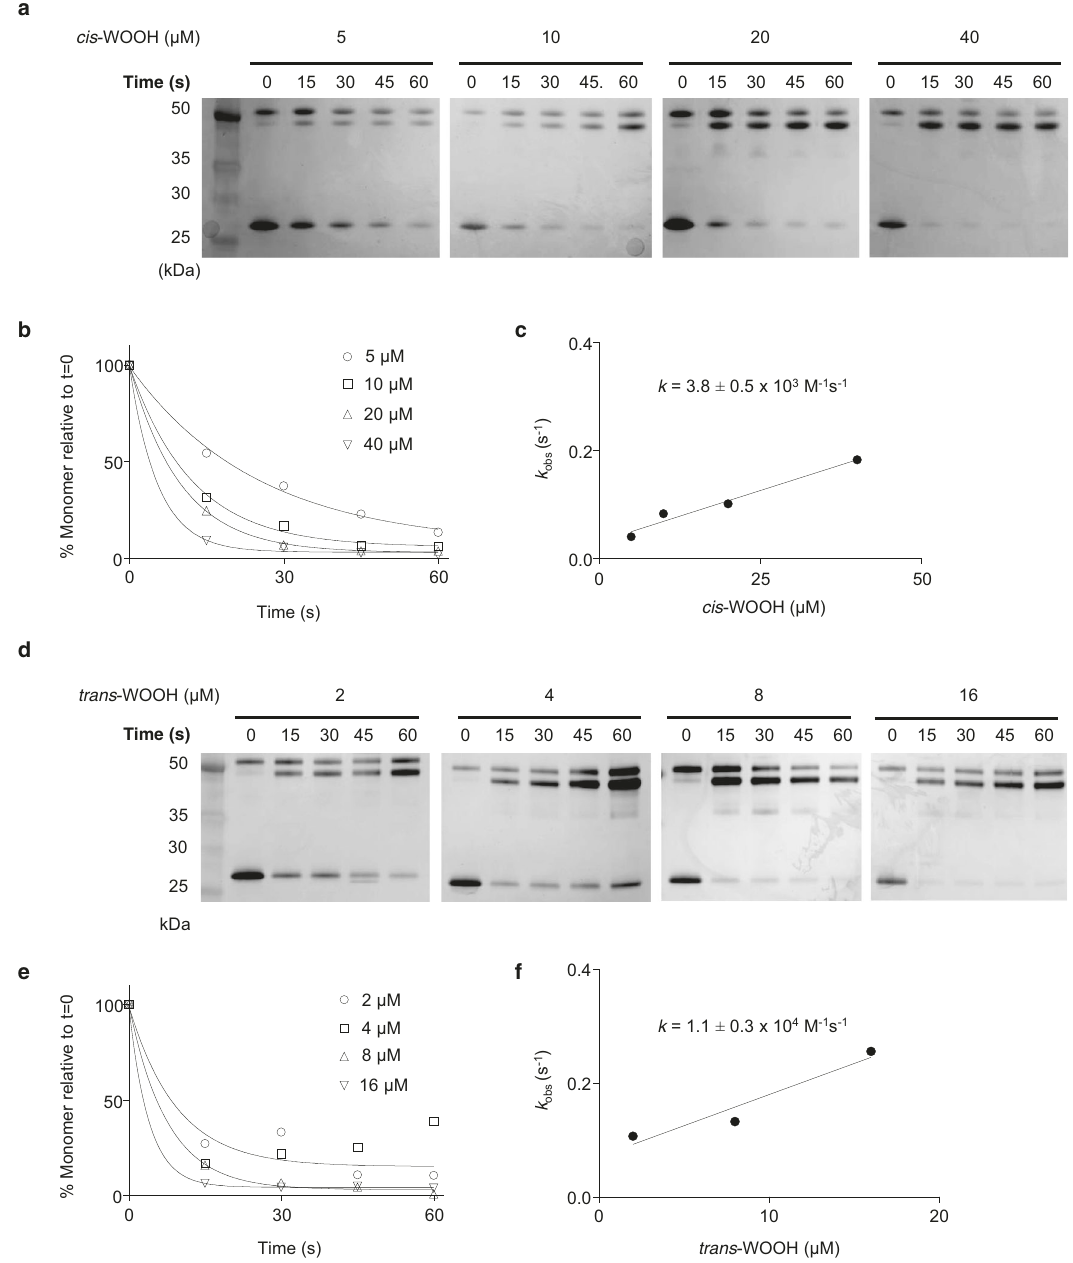
Fig. 3 Estimation of the rate constant for the reaction of cis - and trans -WOOH with His-tagged wild-type Prx2. a Reaction of Prx2 (5 μ M) with cis - WOOH (5 – 40 μ M) at 25 °C. After incubation, N -ethylmaleimide (NEM, 30 mM) was added, and the samples subjected to non-reducing 4 – 12% SDS-PAGE followed by silver staining of the gels. b Time course of monomer disappearance with increasing concentrations of cis -WOOH. c Determination of second- order rate constant for the reaction or Prx2 with cis -WOOH (3.8 ± 0.5 × 10 3 M − 1 s − 1 at 25 °C). d Reaction of Prx2 (5 μ M) with trans -WOOH (2 – 16 μ M) at 5 °C. After incubation, NEM (30 mM) was added, and the samples subjected to non-reducing 4 – 12% SDS-PAGE followed by silver staining of the gels. Uncropped blots are provided in Source data. e Time course of Prx2 monomer disappearance with increasing concentrations of trans -WOOH. f Determination of the second-order rate constant for the reaction of Prx2 with trans -WOOH (1.1 ± 0.3 × 10 4 M − 1 s − 1 at 5 °C). Rate constants values are mean ± SEM. Results shown are representative of three independent experiments. Uncropped blots and source data are provided as a Source data fi